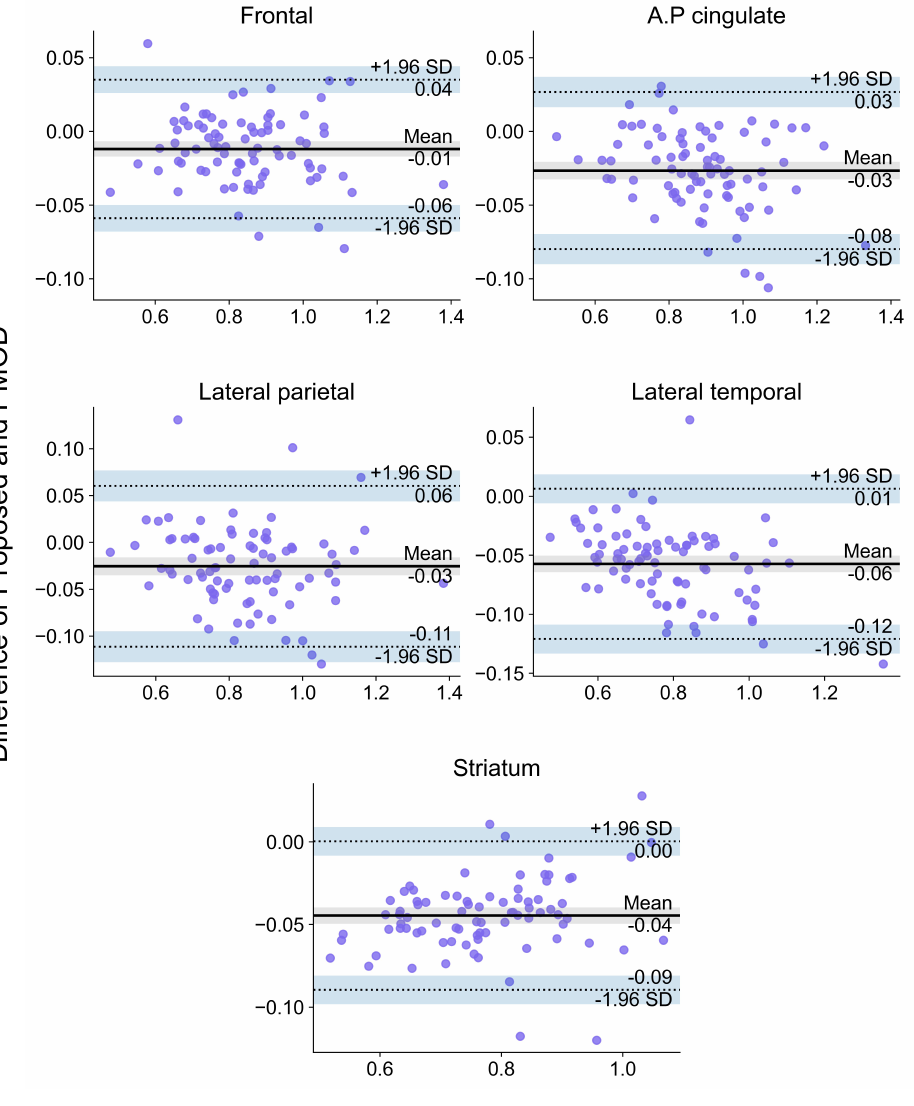
Figure A4. Bland–Altman plot in amyloidosis-positive subject for the comparison of our proposed method and PMOD. A.P. cigulate denotes anterior posterior cingulate